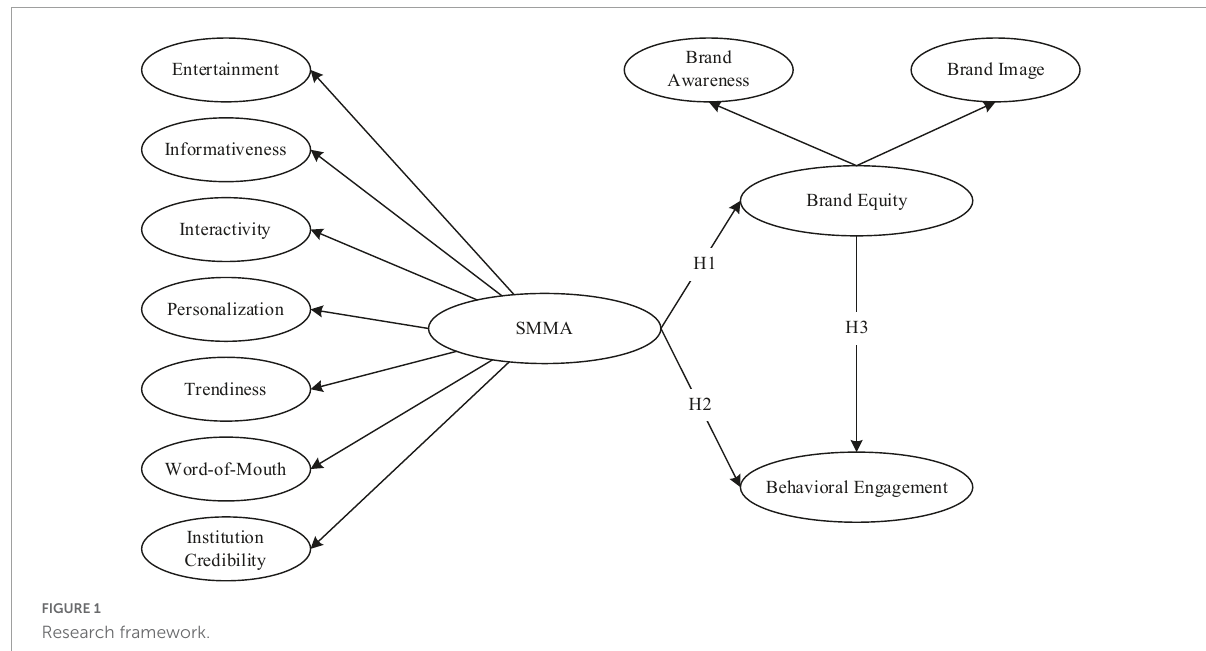
FIGURE1 Research